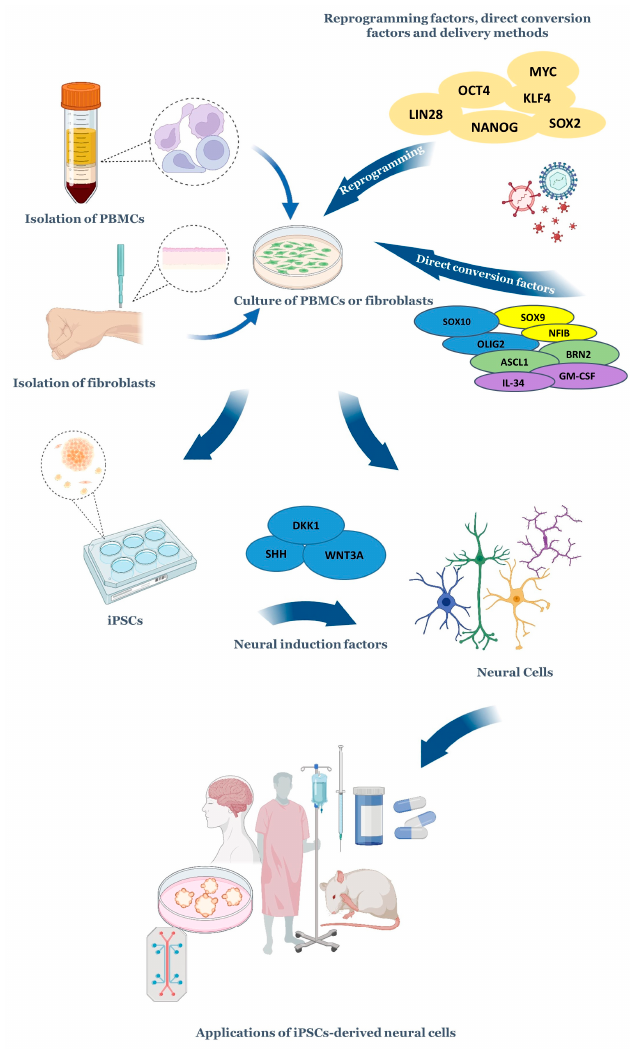
Figure 2. A summary of the process of obtaining and exploiting iPSC-derived neural cells. Somatic cells, such as peripheral blood mononuclear cells and fibroblasts, are typically collected from persons, as these cells are easy and not excessively painful to obtain. After their collection, these cells have different